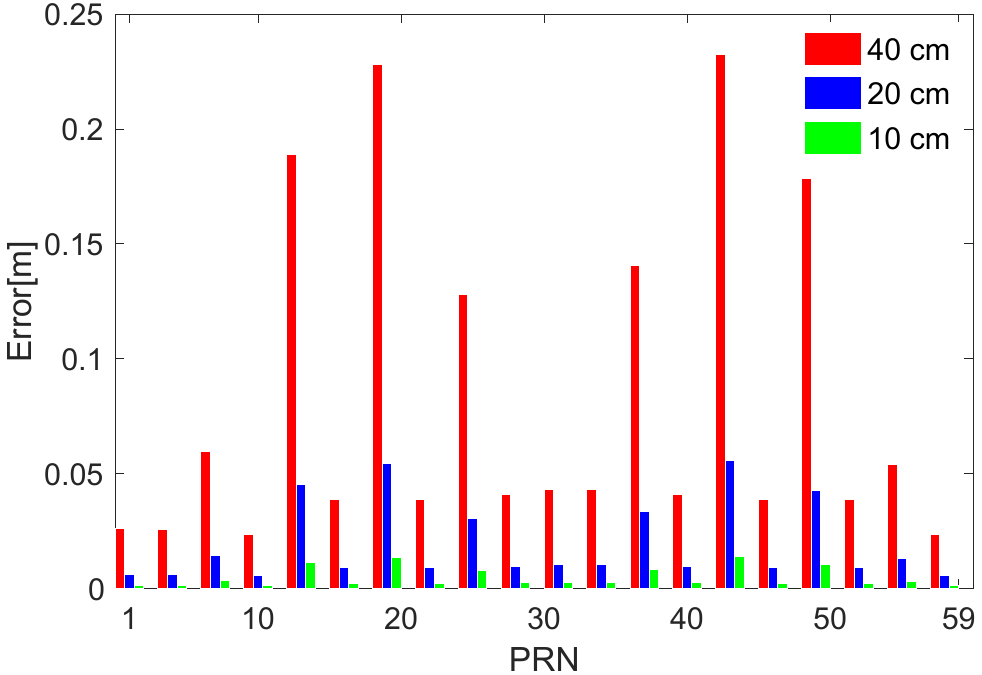
Figure 3. 60-LEO constellation orbital errors in the radial direction under different ranging accuracies.